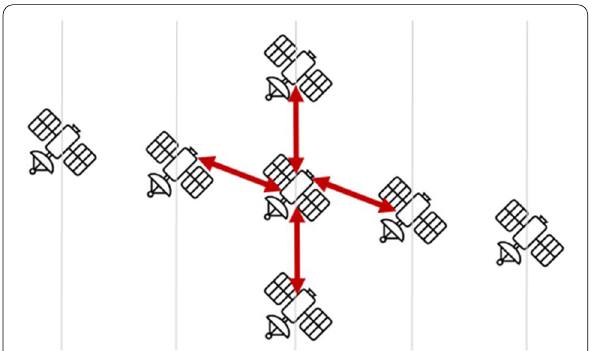
Fig. 1 Illustration of “4-connected” ISL